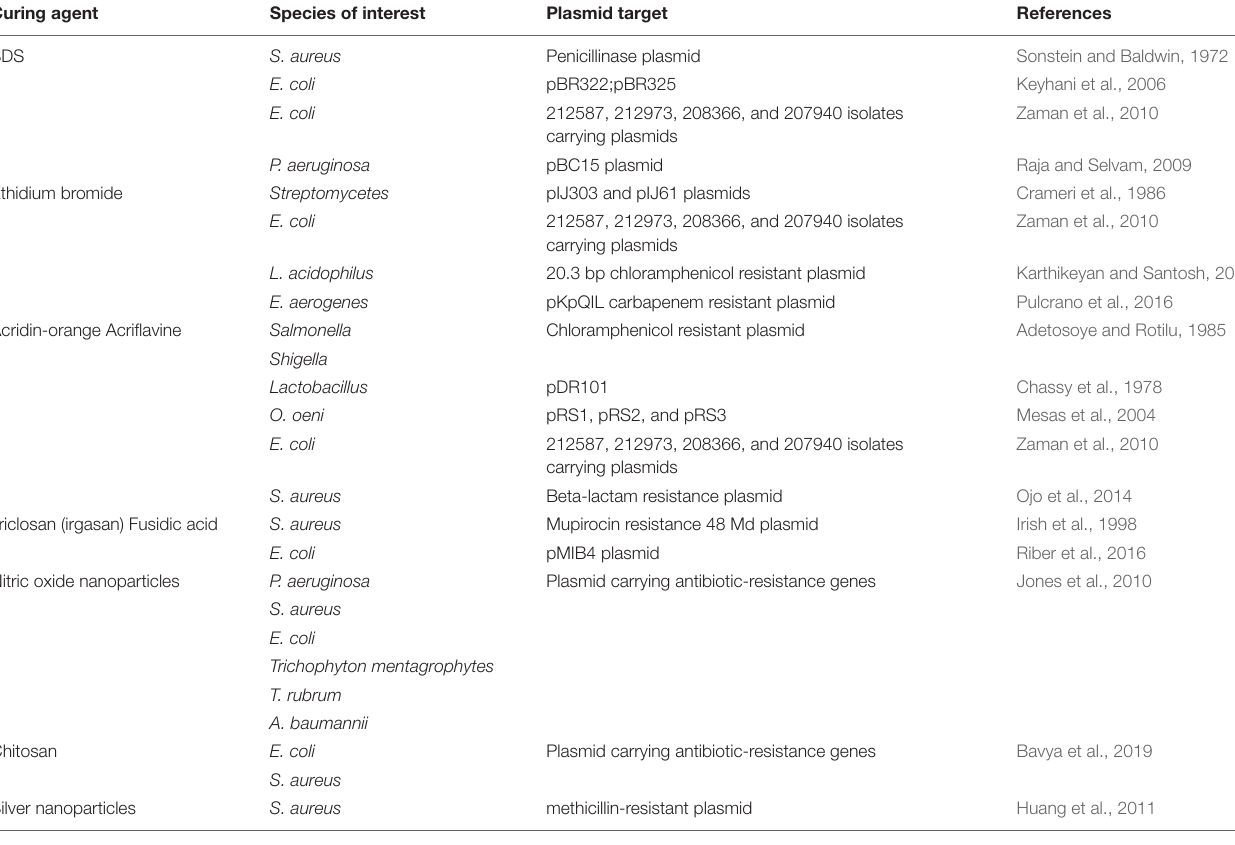
TABLE 1 | Plasmid curing compounds.